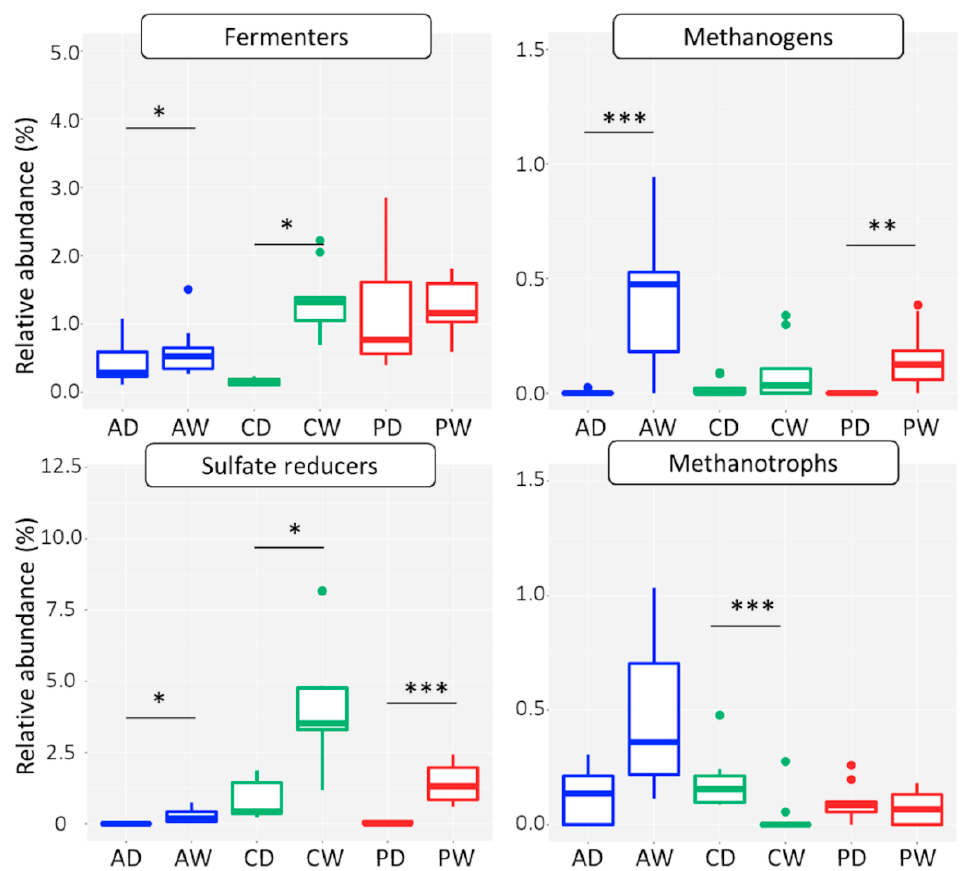
Figure 6. Relative abundance of functional groups in 16S rRNA gene amplicon datasets. Boxplots show relative abundance in depth and triplicate samples. X-axes represent six sites: Alder dry (AD), Alder wet (AW), Coast dry (CD), Coast wet (CW), Perco dry (PD), and Perco wet (PW). Functional groups were assigned from 16S rRNA gene amplicon data by FAPROTAX analysis. Asterisks indicate the significant difference between the drained and rewetted sites (Kruskal-Wallis test, * P <0.05, ** P <0.01, *** P <0.001).